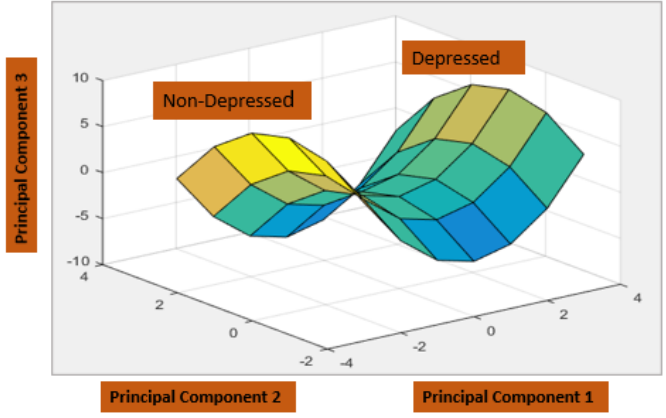
Figure 4. 3-D plot after PCA on robust emotional state